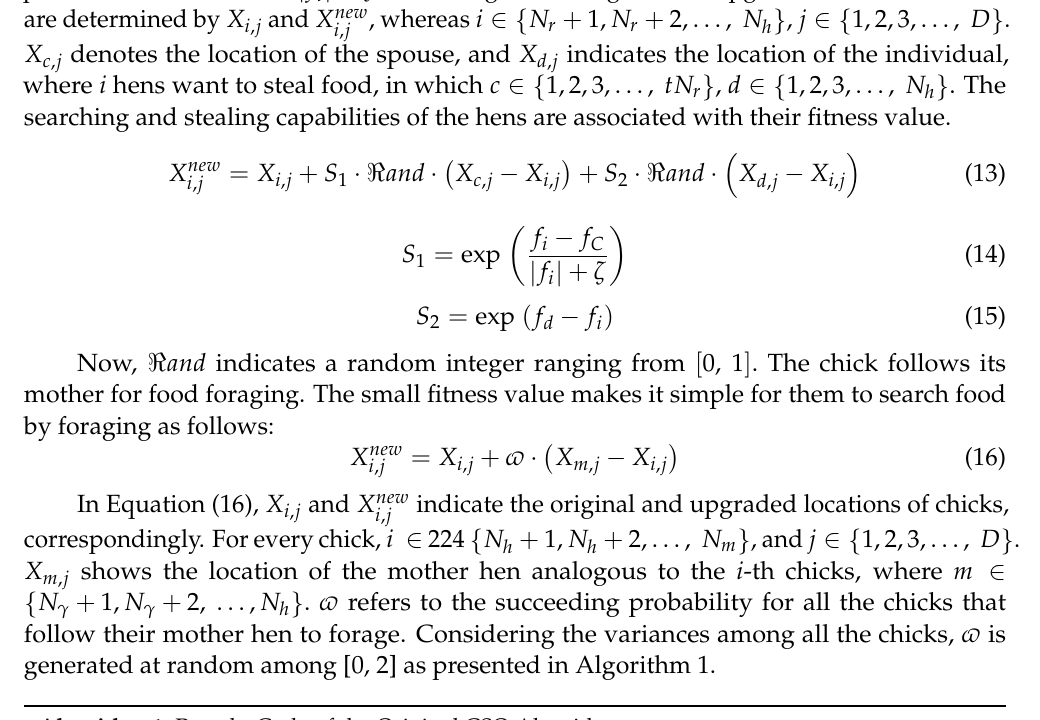
Algorithm 1 . Pseudo-Code of the Original CSO